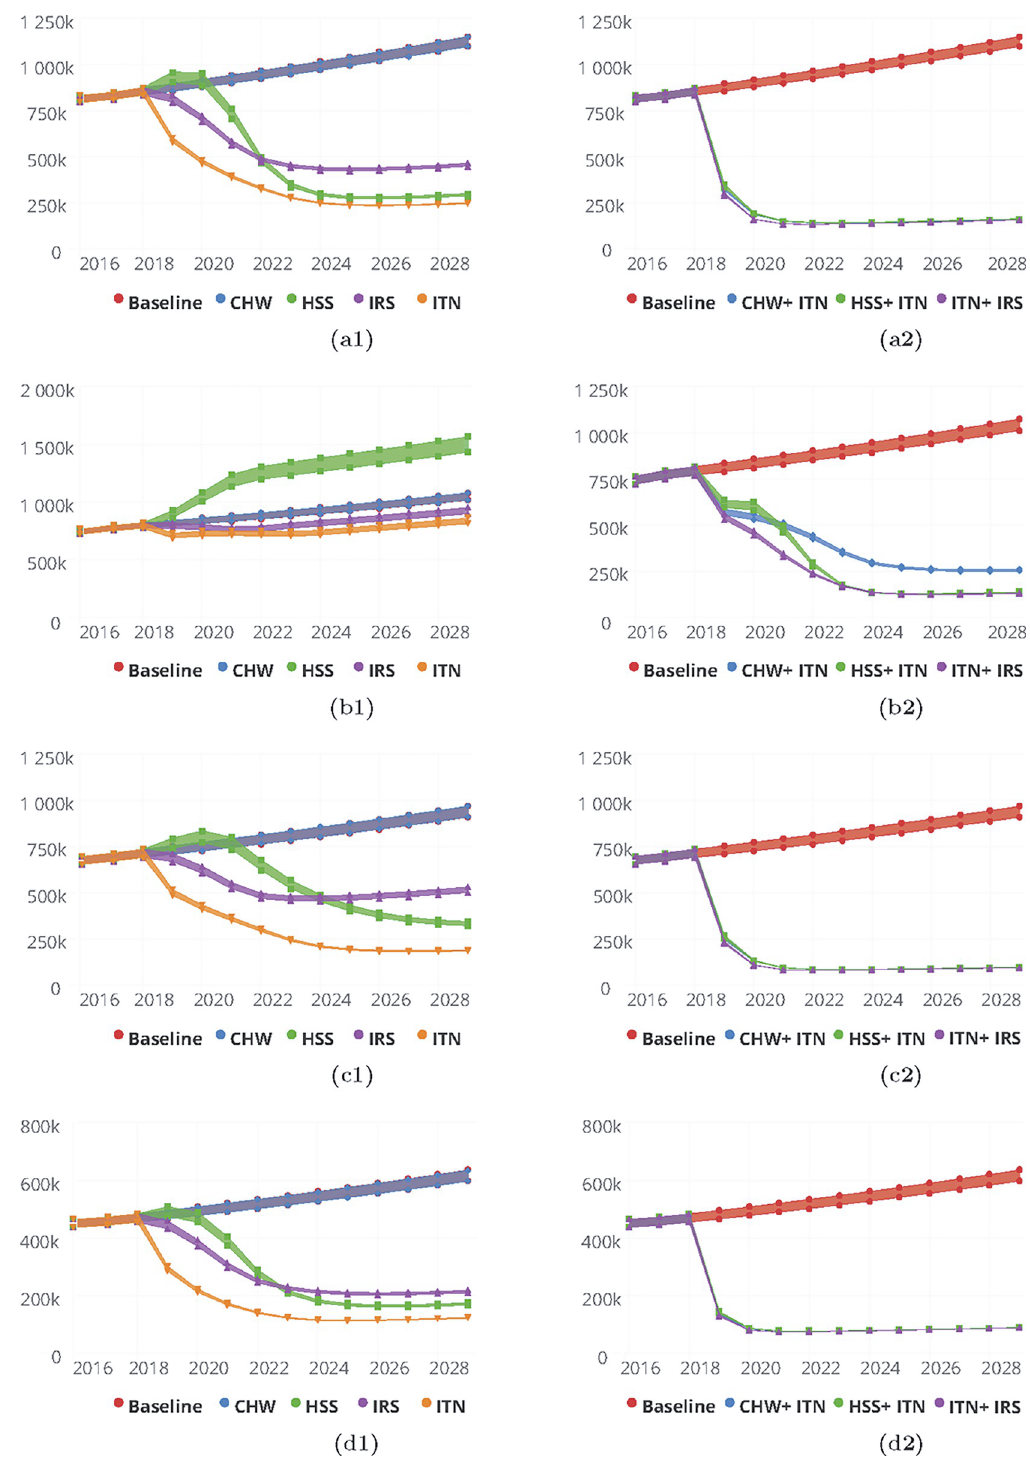
Fig 8. Predictions for malaria incidence for various intervention packages, singly (a1-d1) for Community Health Worker (CHW), Health System Strengthening (HSS), Indoor Residual Spraying (IRS), and Insecticide Treated bednets (ITN) and in combination (a2-d2) for CHW/CHPS + ITN, HSS + ITN and ITN + IRS for the Ashanti (a1 and a2), Brong-Ahafo (b1 and b2), Eastern (c1 and c2) and Volta (d1 and d2) Regions respectively.